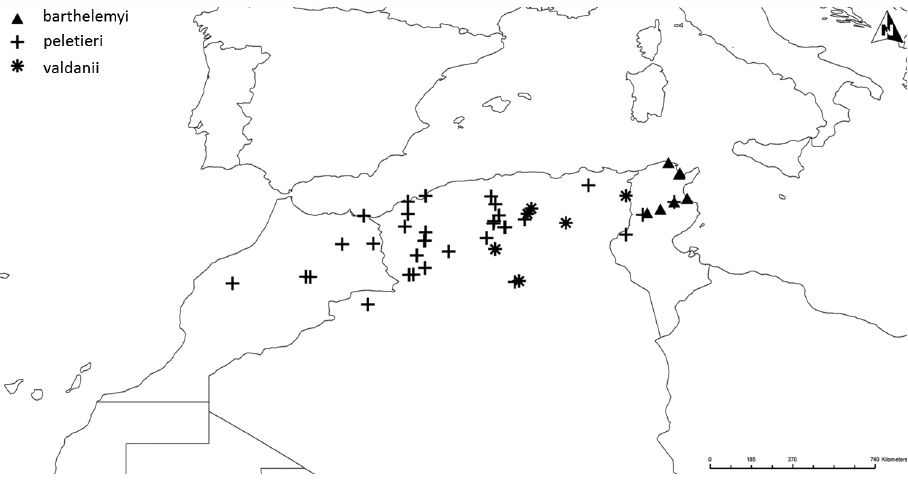
Figure 17. Distributional records of G. barthelemyi , G. peletieri, and G. valdanii.